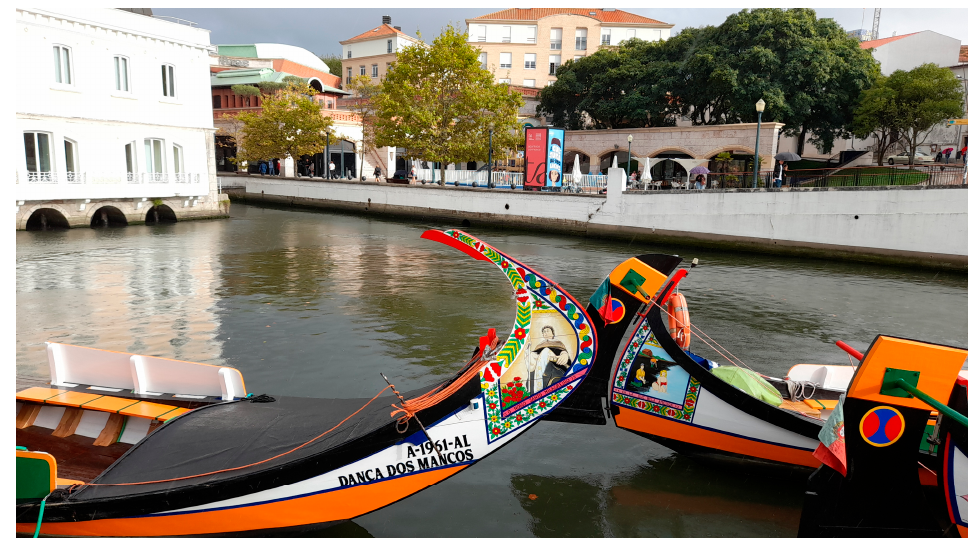
Figure 1. Moliceiros docked on the Central Canal, Aveiro (Source: author’s own photo, 2022).